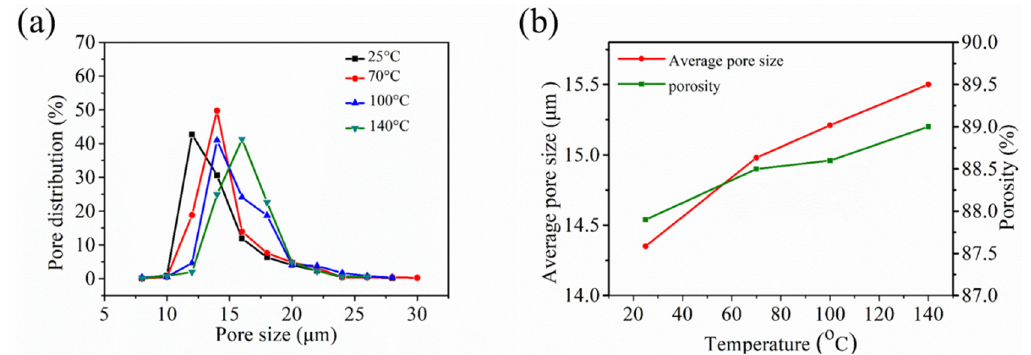
Figure 3. Pore structure of the annealed melt blown samples: ( a ) pore distribution, and ( b ) average pore size and porosity .